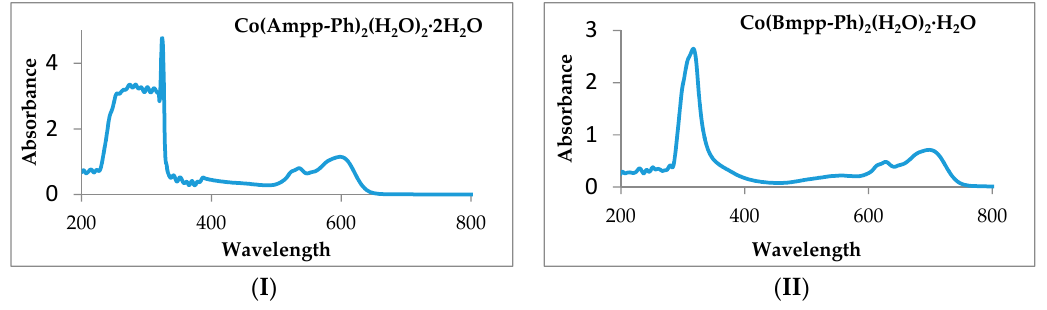
Figure 9. ( I ) Electronic spectra of Co(Ampp-Ph) 2 (H 2 O) 2 ∙ 2H 2 O; and ( II ) electronic spectra of Co(Bmpp-Ph) 2 (H 2 O) 2 ∙ H 2 O.